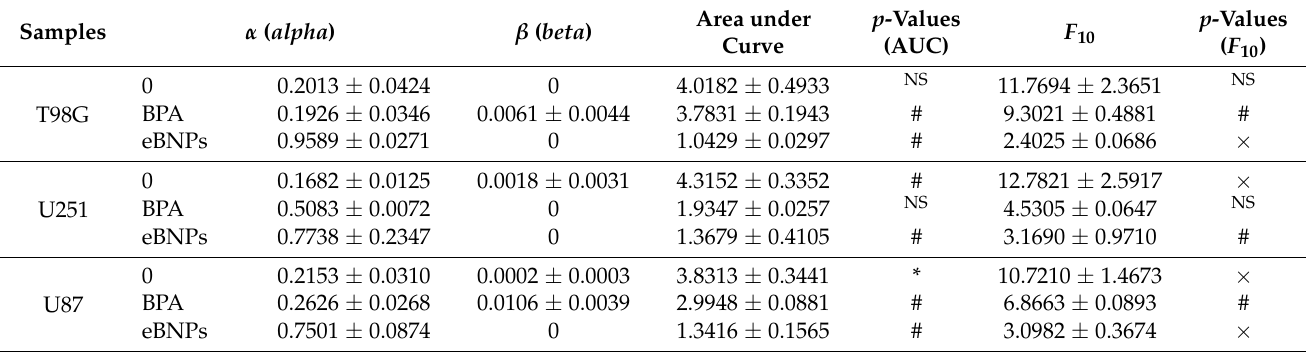
Table 3. Radiobiological